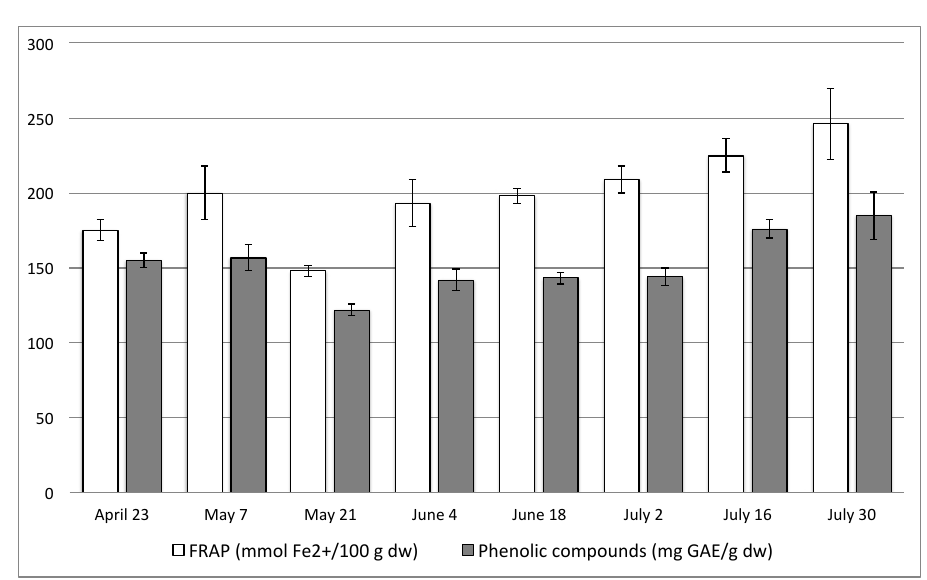
Fig. 2. Antioxidant capacity (FRAP analysis) and content of total phenolic compounds (Folin-Ciocalteu analysis) of sea buckthorn leaves (averages for separate samples of cvs ‘Otradnaja’, ‘Gibrid Pertjika’ and ‘Ljubitelskaja’). GAE = gallic acid equivalents. Error bars represent standard